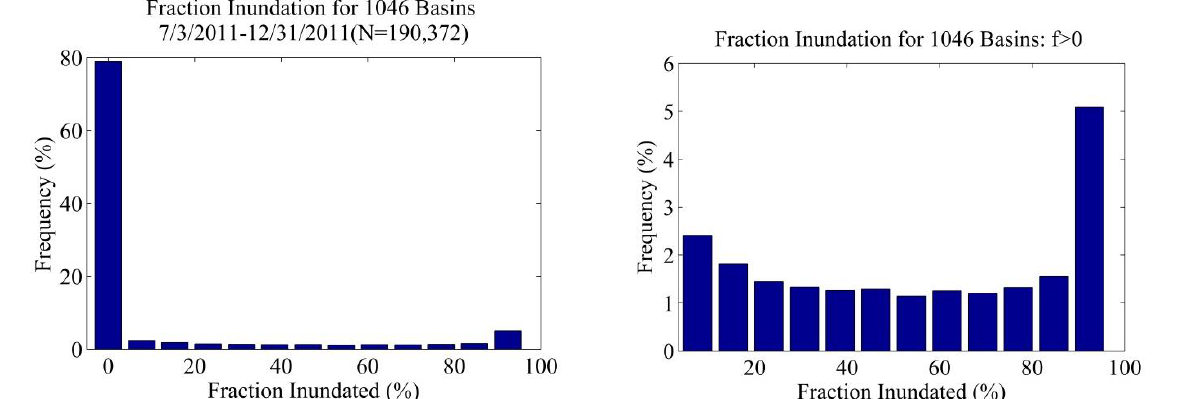
Figure 10. Frequency of fractional inundation for low lying regions of southeast Asia over the study time period ( left ), and the frequency of percent inundated, f, greater than zero for study time period ( right